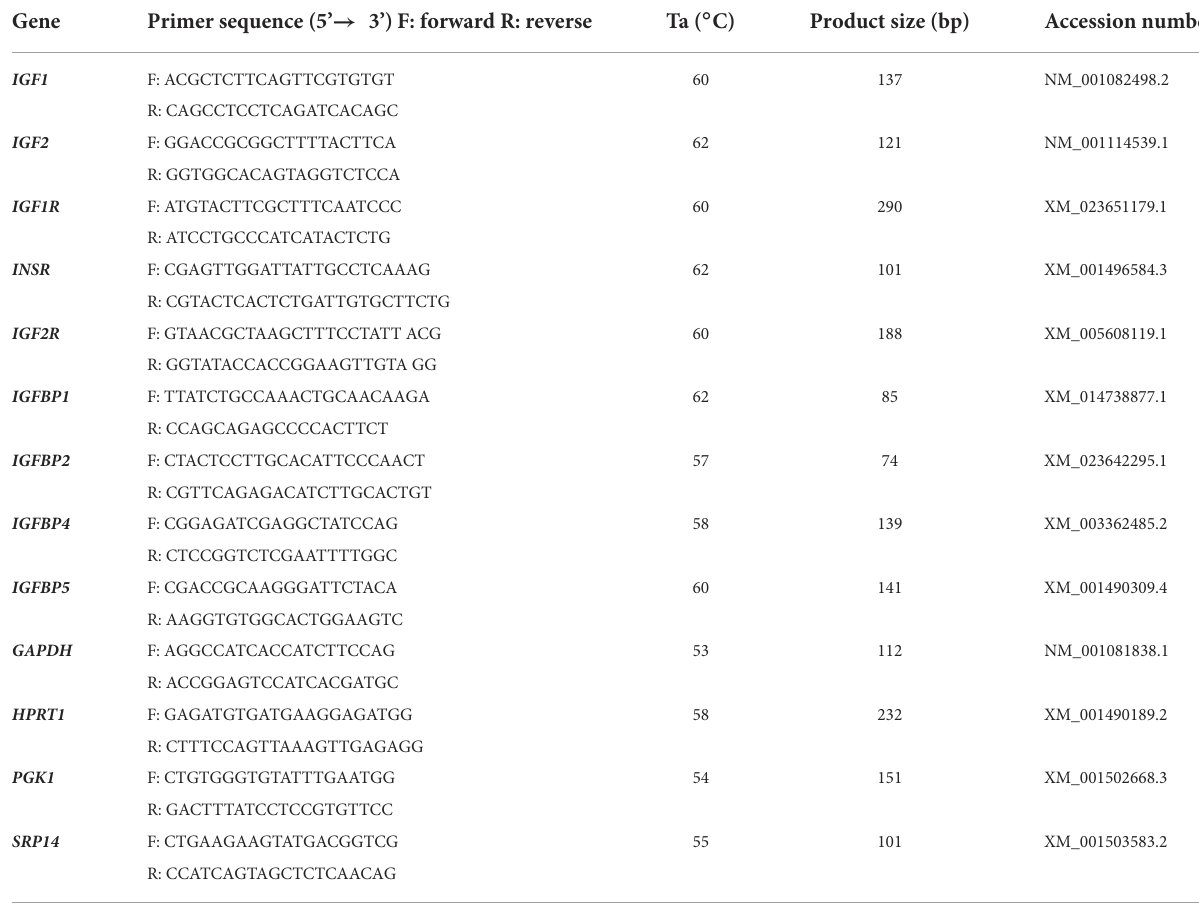
TABLE 1 Primer pairs for equine IGF system components; gene symbol, primer sequence, annealing temperature, product size and accession number of genes used for qRT-PCR analysis. Gene Primer sequence (5’ → 3’) F: forward R: reverse Ta (